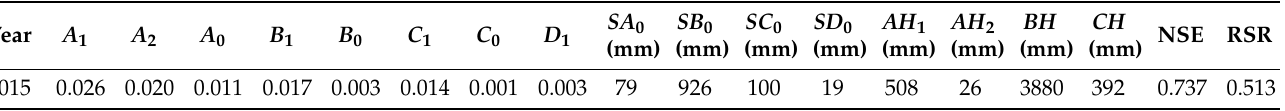
Table 4. The best performing tank model parameter sets for Atari River catchment during model calibration in 2015.